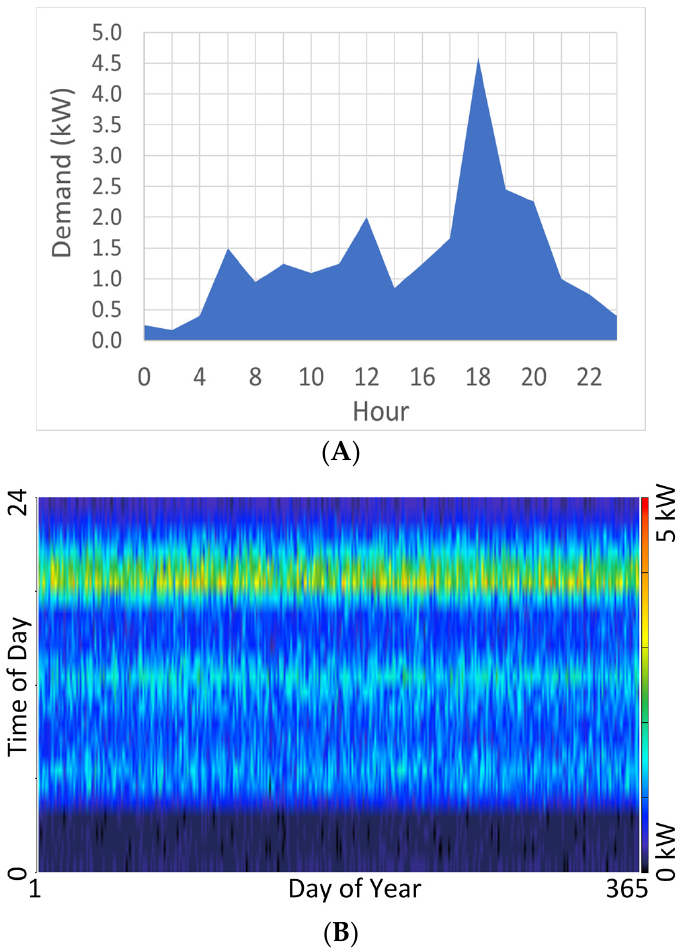
Figure 1. Generic residential building energy consumption profile considered for the analysis: ( A ) time of the day and ( B ) day of the year demand.